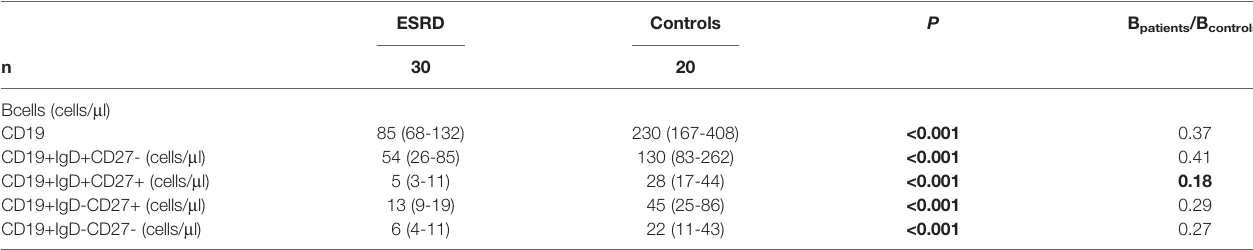
Bold values signify statistical signi fi